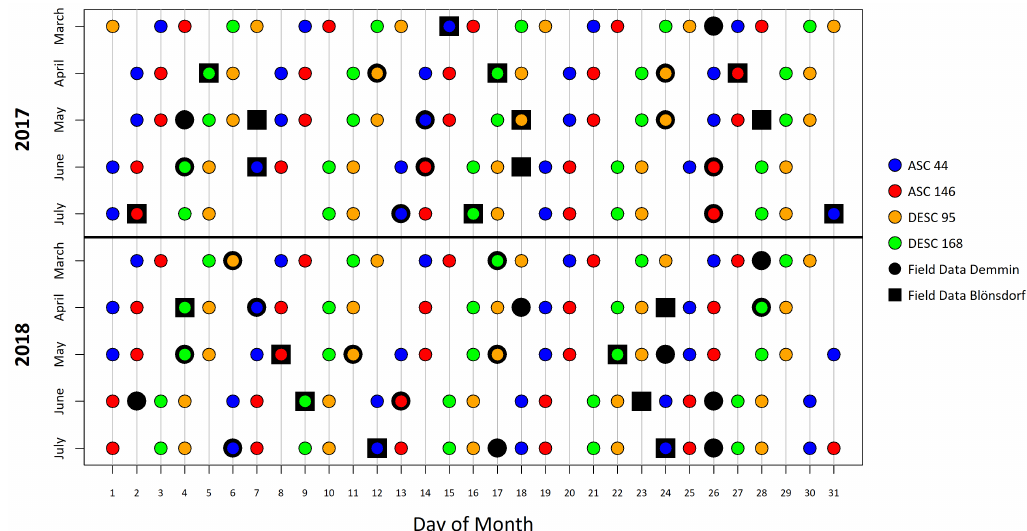
Figure 2. Sentinel-1 acquisitions and field measurement dates 2017 and 2018: the data gaps resulted from unavailable images at the time of